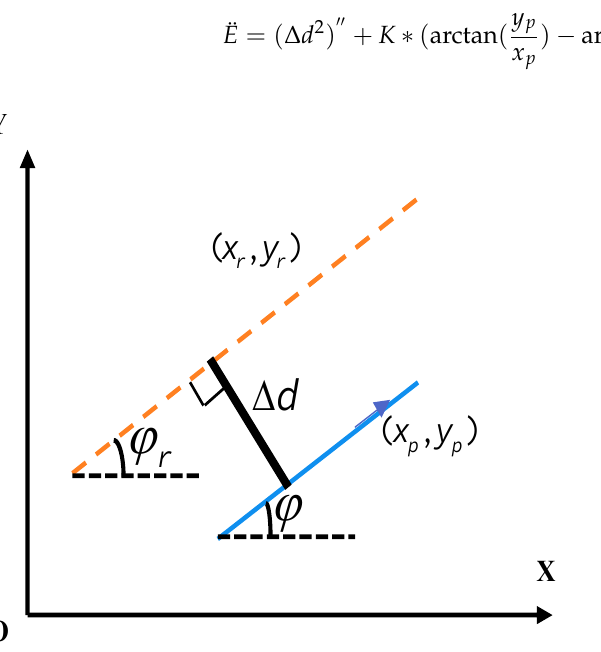
Figure 7. Mechanism of linear trajectory